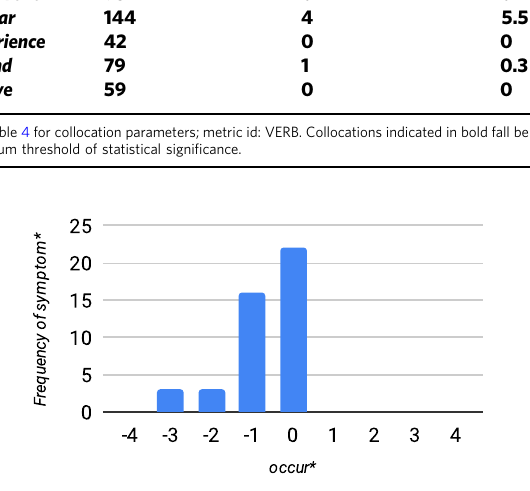
Fig. 2 Distribution of lemma of SYMPTOM with respect to conjugations of verb at node = 0. Verb occur with symptom in English core corpus, standard deviation from mean, μ = − 1.41, σ = 0.73. Starred items denote noun and verb forms rather than tokens.